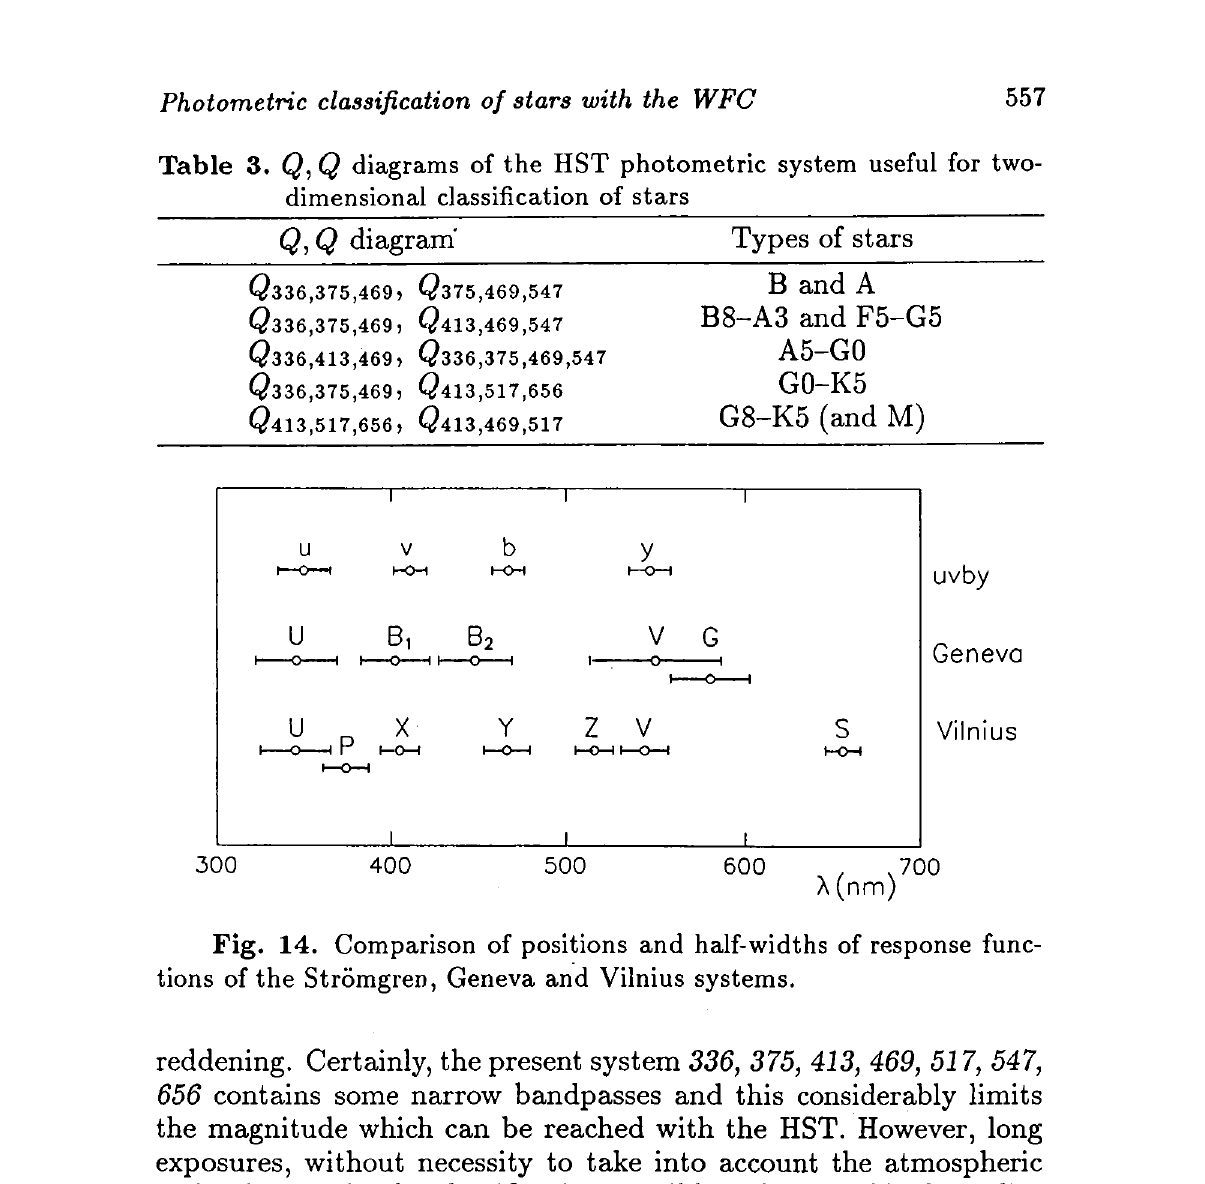
Table 3. $, $ diagrams of the HST photometric system useful for two-